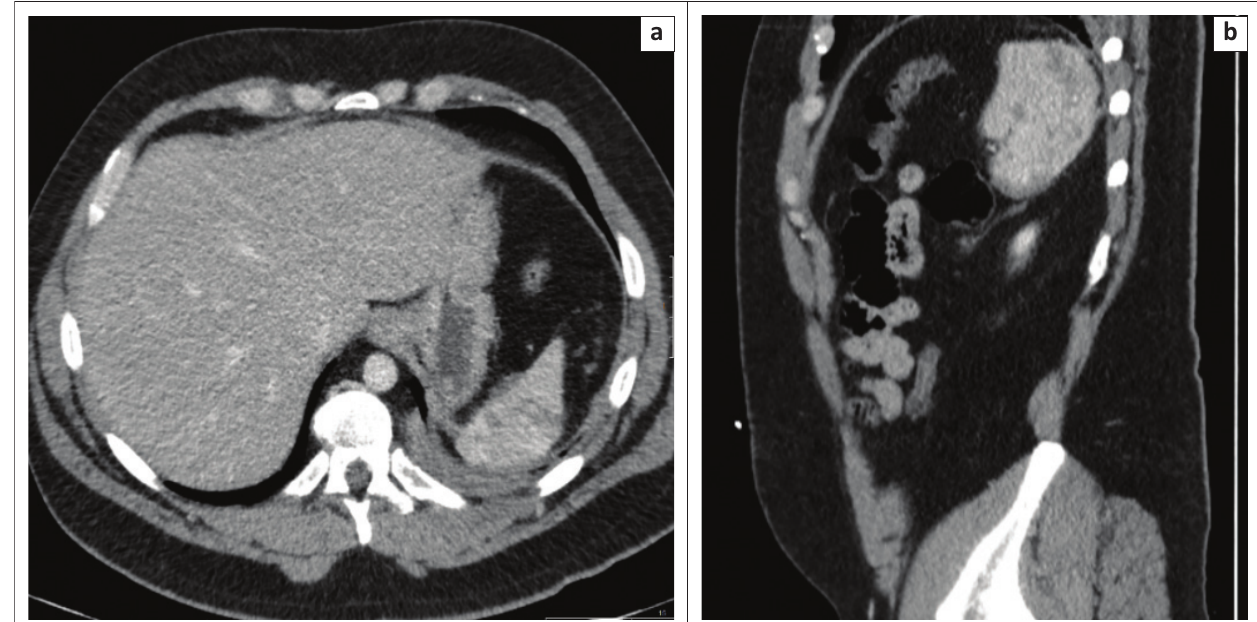
FIGURE 1: (a) Axial and (b) coronal images on the day of admission, showing multiple lacerations of the spleen with a subcapsular haematoma.